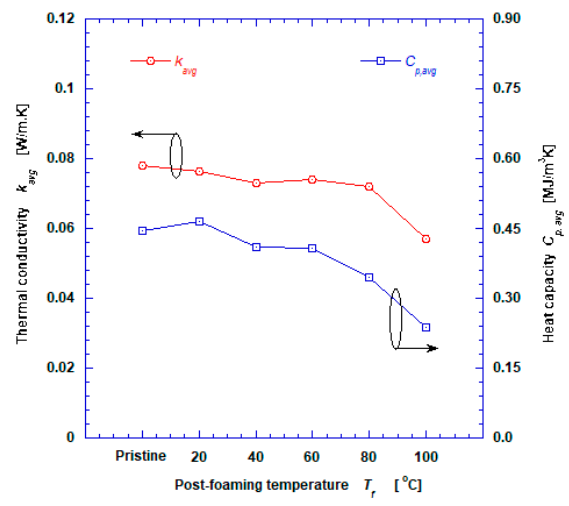
Figure 6. Effects of average thermal conductivity and heat capacity on the post-foaming temperature in 3D grid foam structure of the copolymer.